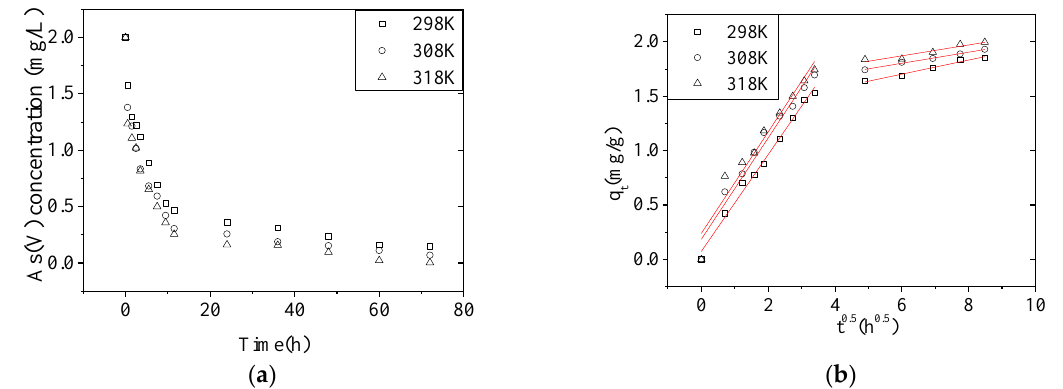
( b ) Figure 4. Effect of the pH on the As(V) removal rate. ( a ) Effect of the pH on the As(V) removal rate as a function of time. ( b ) Intraparticle diffusion model fit for the As (V) removal rate by NZVI/AC at different pH values (conditions: C 0 = 2.0 mg/L, 150 rpm, 20 × 40 mesh particle size, t = 72 h, T = 298 K, adsorbent dosage = 1.5 g/L, pH = 3.5, 6.5, and 9.5).